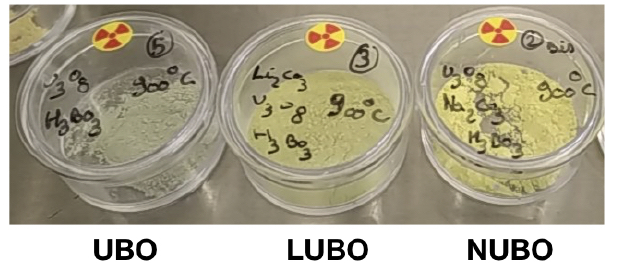
Figure 1. Variation of the color of the obtained powder samples from UBO (left) to NUBO